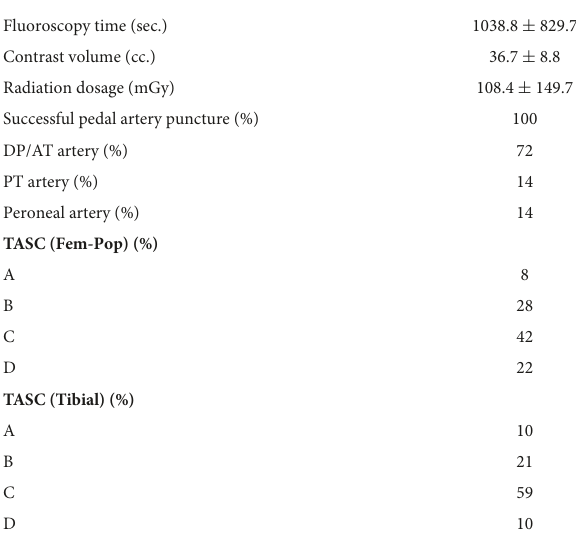
TABLE 2 Procedural